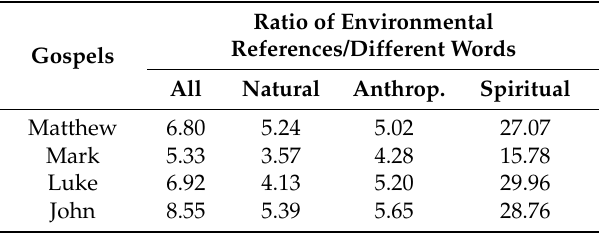
Table 4. Ratio of environmental references/unique words according to the General Environmental